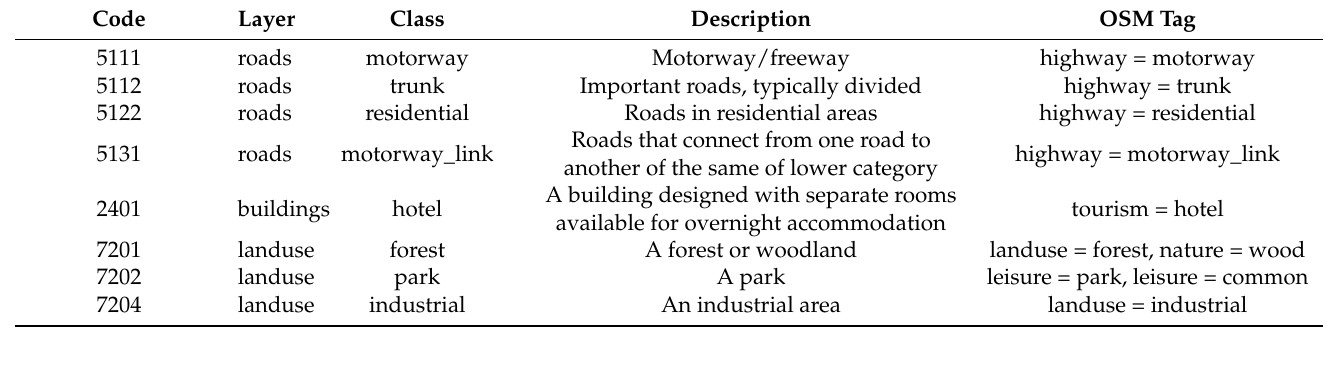
Table 1. Part of the OpenStreetMap Data in Layered GIS Format.